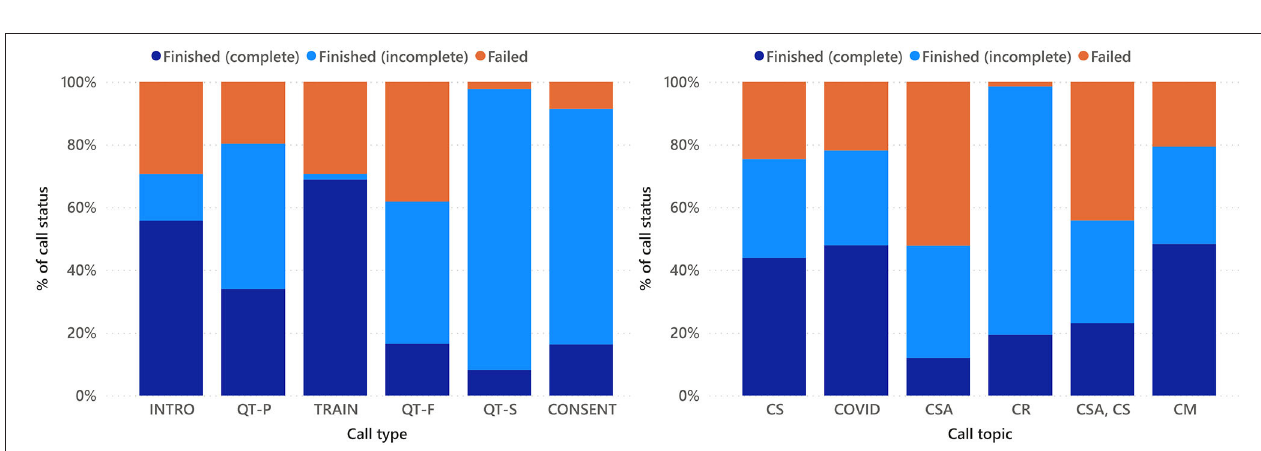
FIGURE 5 | Call status per survey type (left) and survey topic (right). Different survey types are one-block (listen-only) voice messages (INTRO), multi-block question-trees on perceptions (QT-P), feedback (QT-F) and surveys (QT-S), initial calls for obtaining the respondent’s consent (CONSENT), and test- and training calls (TRAIN). Topics included calls about climate services (CS), impacts from the covid-19 pandemic (COVID), climate-smart agriculture (CSA), climate risks (CR), crop management (CM), and combinations.